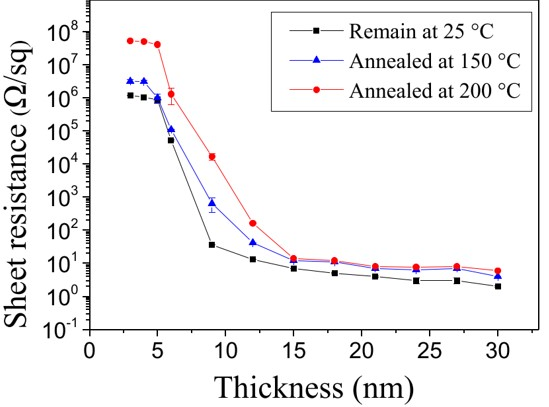
Figure 6. Relationship of the sheet resistance of dewetted silver films vs. the original thicknesses of the silver films prior to dewetting at different annealing temperatures.